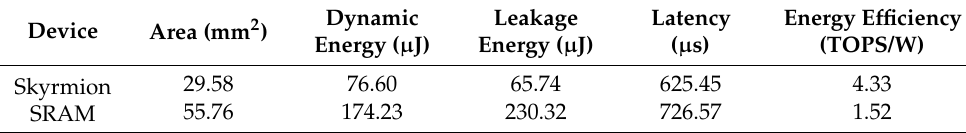
Table 2. Validation performances for different devices